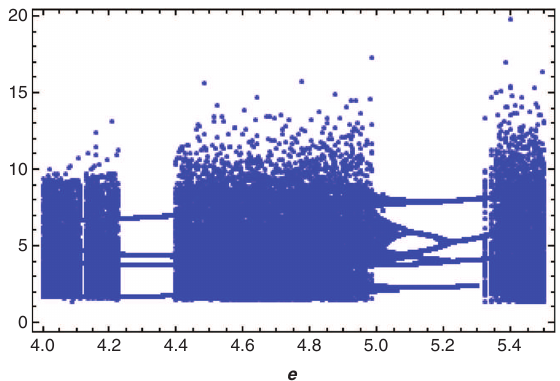
1206 | R.H. AL-Hashemy and S.A. Mehdi: A New Algorithm Based on Magic Square